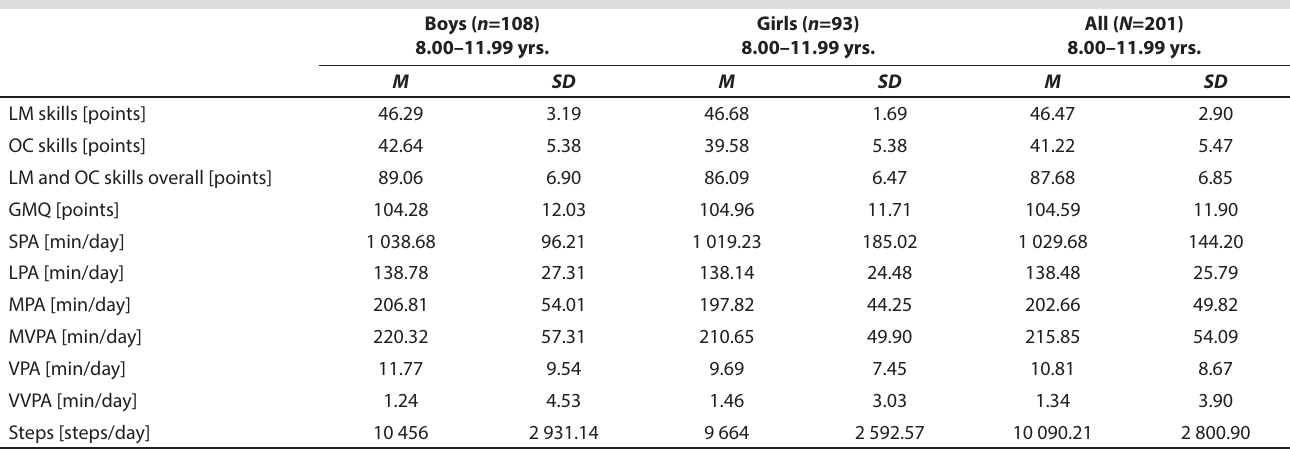
TABLE 1 Results of FMS and PA levels (N =